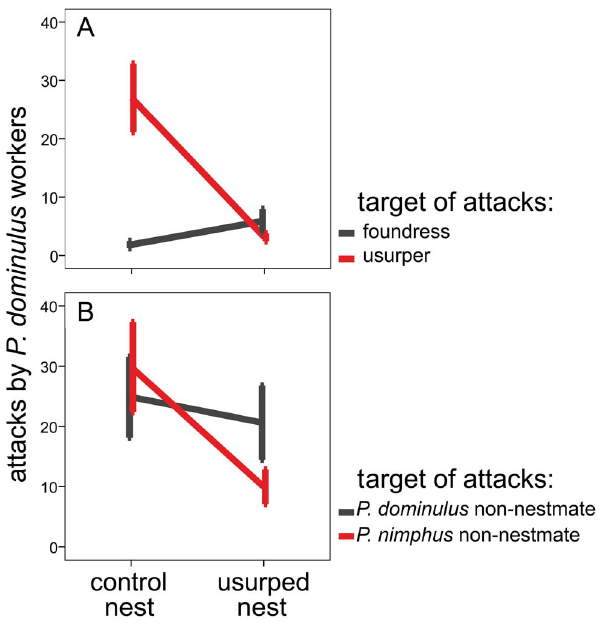
Figure 2. Behavioral tests. The results of the behavioral tests as the mean number of attacks ( 6 SE) that P. dominulus workers displayed against the stimulus wasps. A) Workers from the two nest parts responded differentially to foundresses and usurpers – attacks to usurpers (but not foundresses) dropped in usurped nests, relatively to control nests - and (B) sisters from the two nest parts responded differentially to the non-nestmates of the two species - attacks to P. nimphus non-nestmates (but not those to P. dominulus non-nestmates) dropped in usurped nests, relatively to control nests. doi:10.1371/journal.pone.0065107.g002 those used for GC. After the identification of the compounds, we calculated the relative abundance of each compounds by an automatic function of the program ‘‘Standard ChemStation’’.